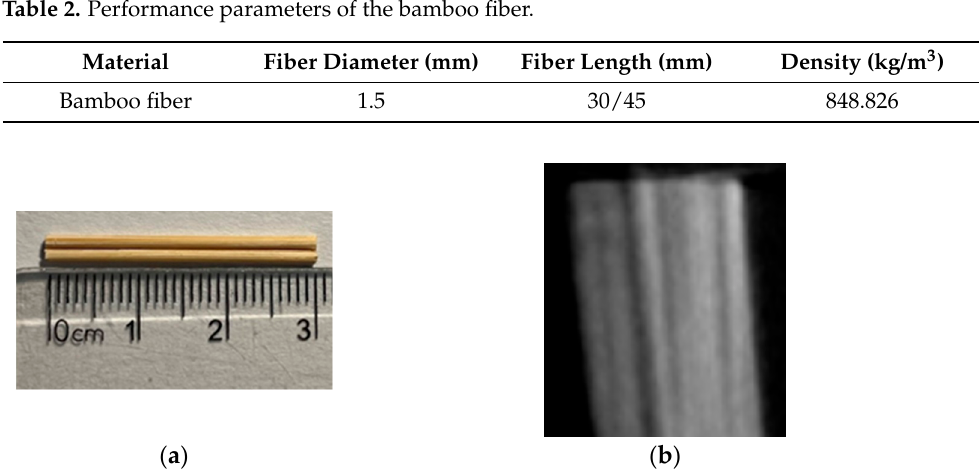
Table 1. Mixture ratio of the concrete. Table 2. Performance parameters of the bamboo fiber.